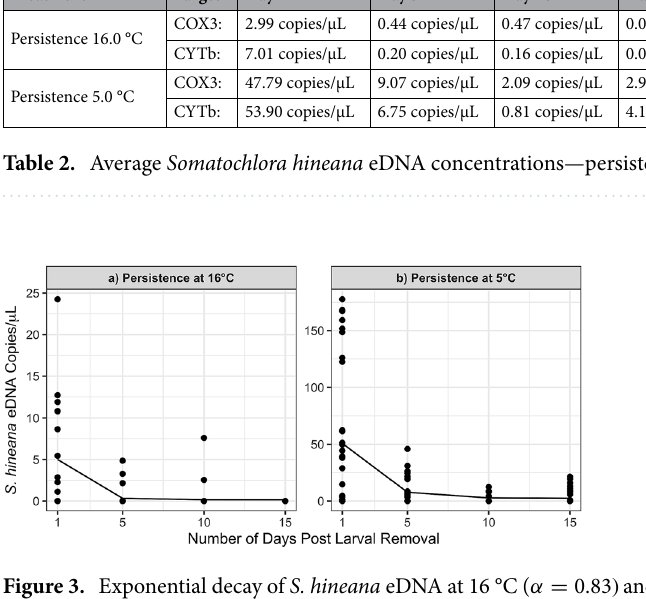
Figure 3. Exponential decay of S. hineana eDNA at 16 °C ( α = 0.83 ) and 5 °C ( α = 0.55 ) days 1, 5, 10, and 15 post larval removal. Note: parts ( a ) and ( b ) display different